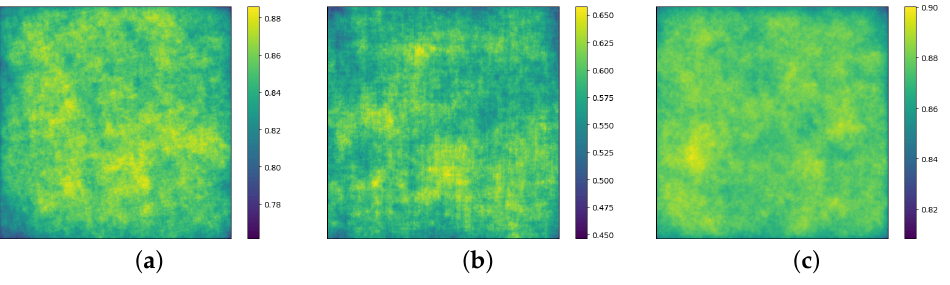
Figure 7. Average accuracy distribution of feature maps at 512 × 512 patch-size on different datasets. ( a – c ) are accuracy distributions on testsets of the Potsdam, the Evlab, and the Songxi